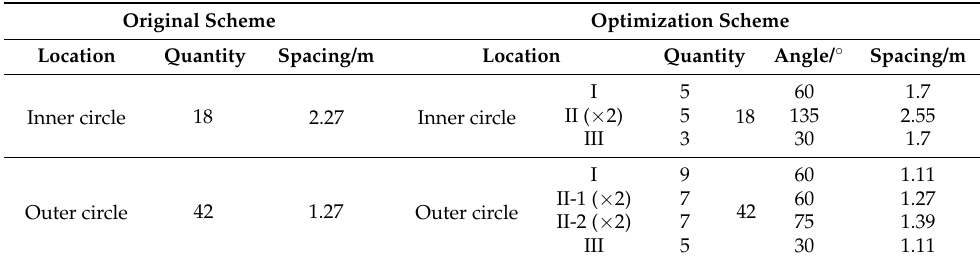
Table 8. Design parameters of double-circle freezing optimization scheme.